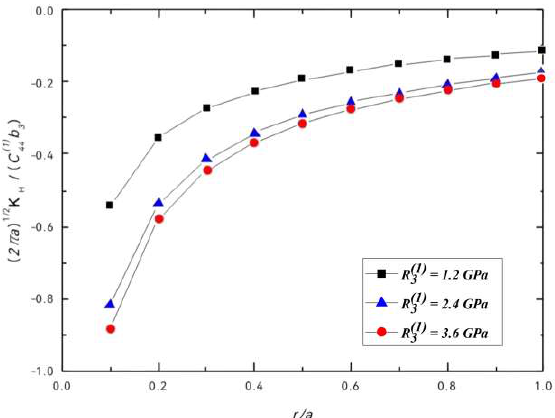
( 1 ) b 3 ) vs. r / a . 44